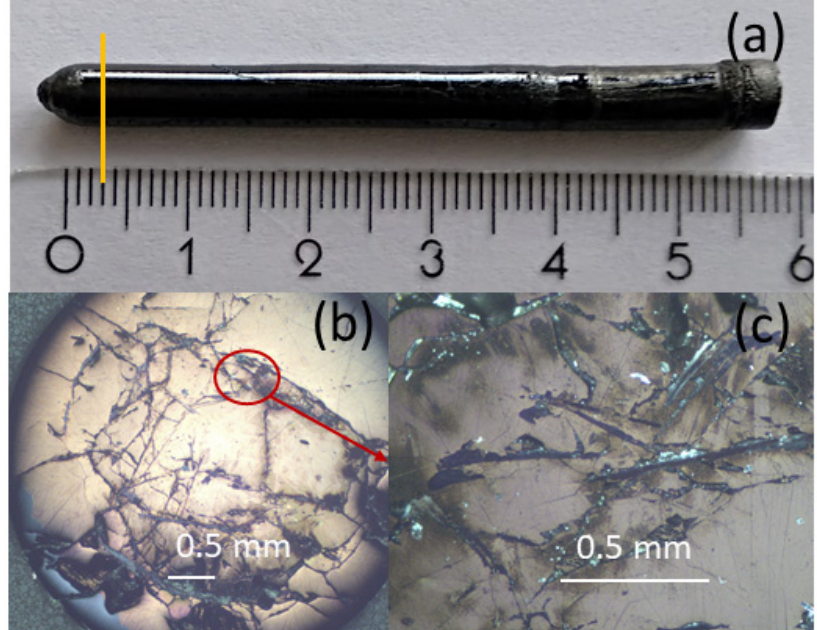
Figure 4. ( a ) Ingot of La 1.61 Sr 0.19 Eu 0.2 CuO 4 , grown at an oxygen pressure of 9 bar using Eu-containing solvent. The yellow line indicates the position of the cross section in ( b ). ( b ) Polarized microscopy photography of the cross section indicated in ( a ). The zone highlighted in red is shown at higher magnification in ( c ).